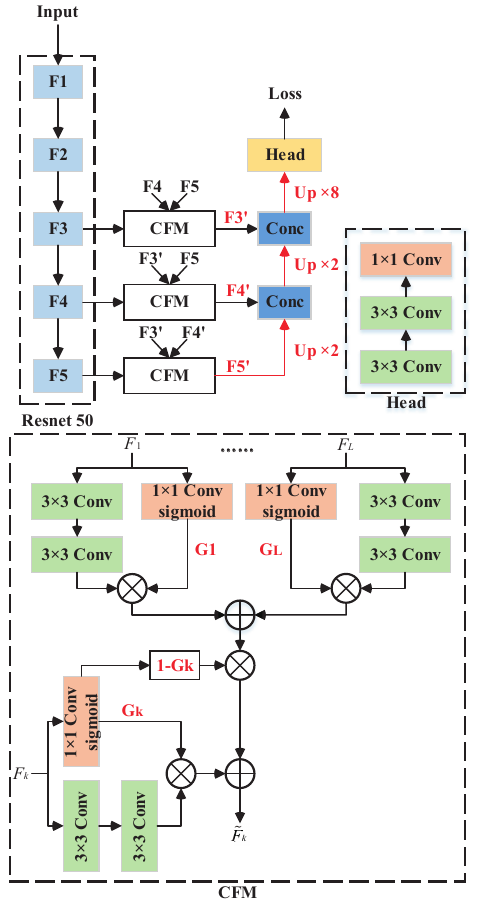
Figure 5. FCN with CFM. The CFM module is applied in F3, F4 and F5 in Resnet-50, and the details of CFM are shown at the bottom. The red lines represent